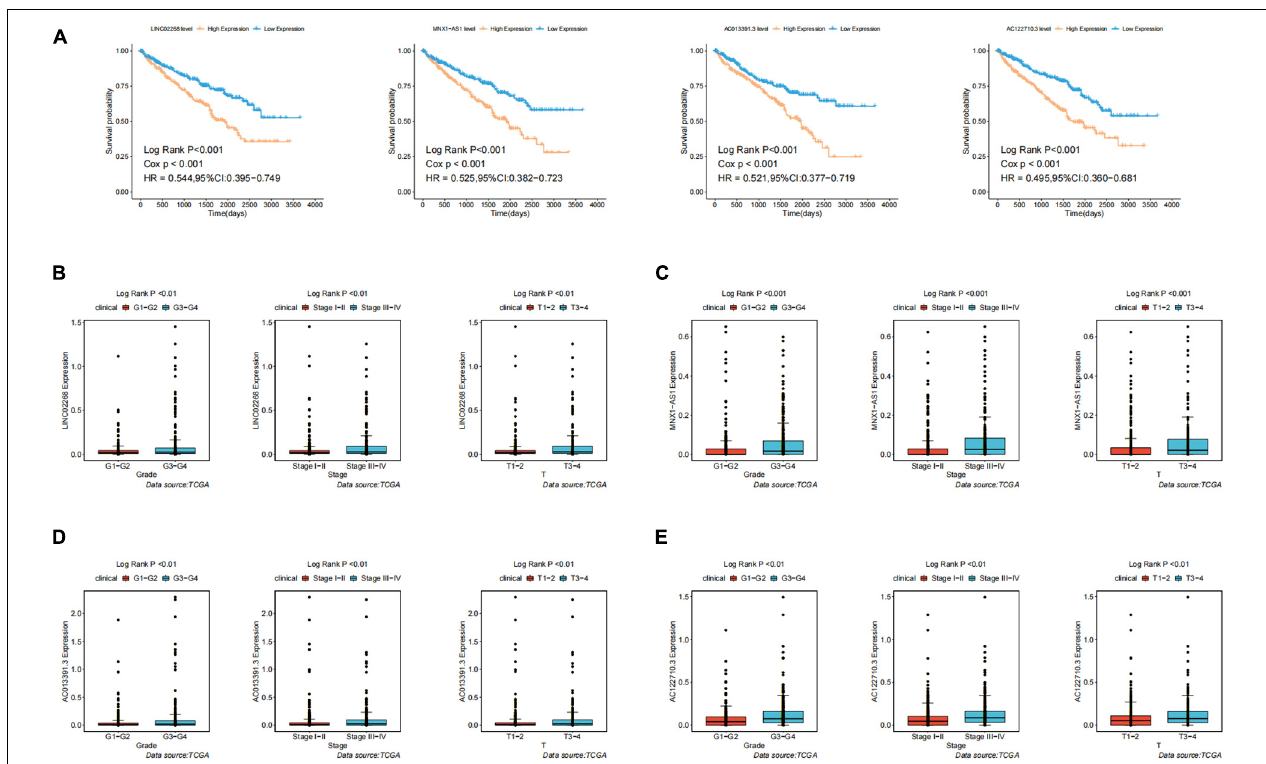
FIGURE 5 | Identification of the clinical characteristics and overall survival of genomic instability-derived lncRNAs in GILncSig. (A) Kaplan–Meier curves of overall survival of MNX1-AS1, AC013391.3, AC122710.3, and LINC02268. (B) Boxplots of LINC02268 expression level in different clinical factors like Grade, T stage, and Stage. The expression level of LINC02268 was significantly associated with poorer prognosis and the increasing level of clinical factors. (C) The expression level of LINC02268 was significantly associated with poorer prognosis and the increasing level of clinical factors. (D) The expression level of AC013391.3 was significantly associated with poorer prognosis and the increasing level of clinical factors. (E) The expression level of AC122710.3 was significantly associated with poorer prognosis and the increasing level of clinical